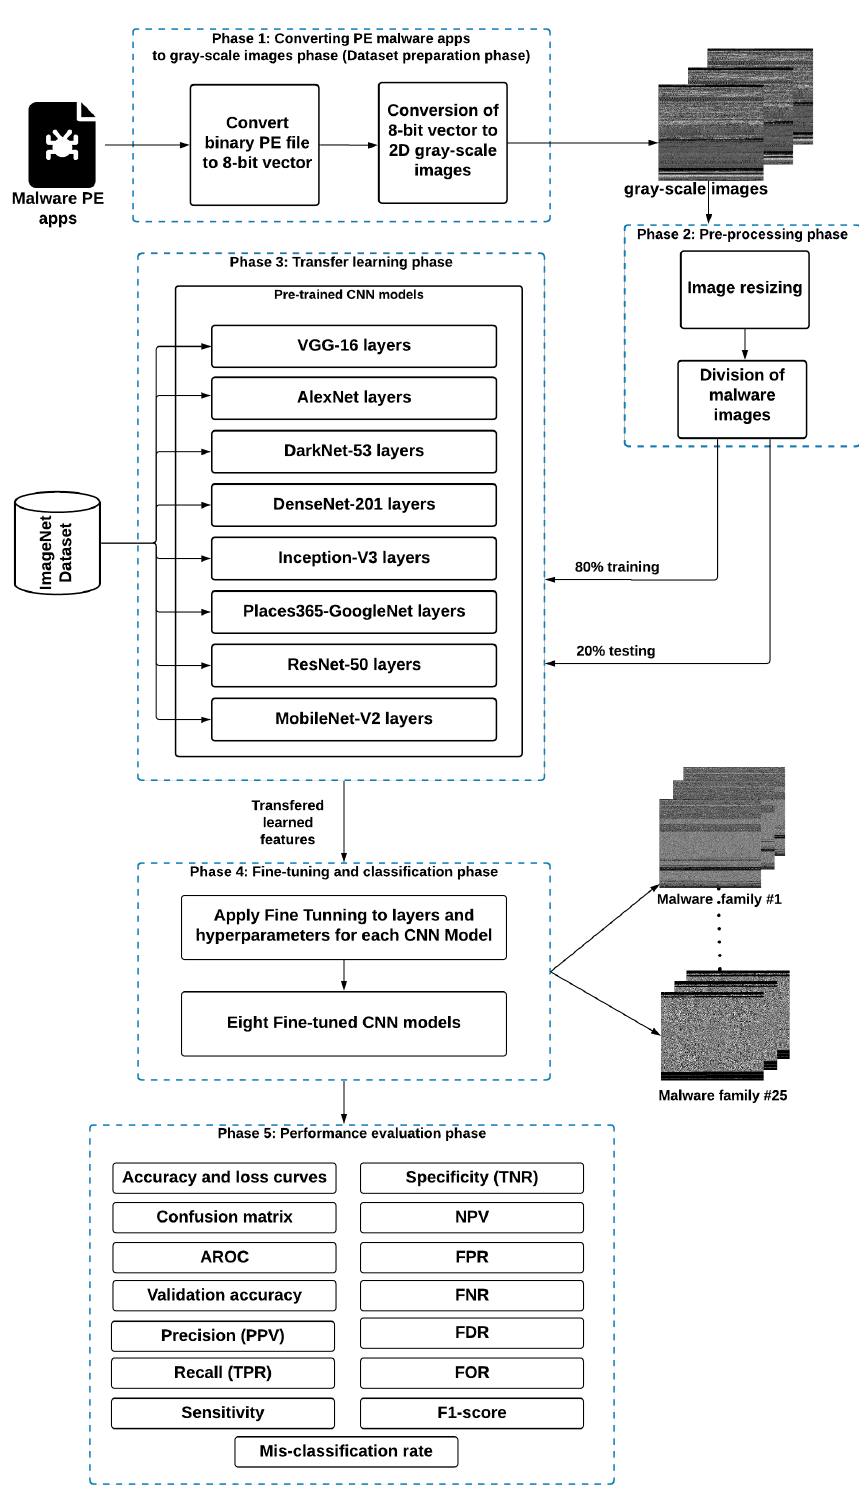
Figure 1. Proposed visualized malware multi-classification